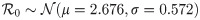
Sensitivity analysis of the quantity I + D + A + R + T in the SIDARTHE model on uncertainty in epidemiological model parameters.The y-axis has a linear scale for better visibility of differences across plots. Simulations in each row have fixed period length. Simulations in each column have fixed duty-cycle apart from the right-most column, which shows the effect of the outer loop. Parameters were sampled from zero-truncated Normal distributions with means σ1, …, σ16 and 10% standard deviation. β was estimated from samples of the basic reproduction number R0∼N(μ=2.676,σ=0.572) representing the consensus distribution in [39].